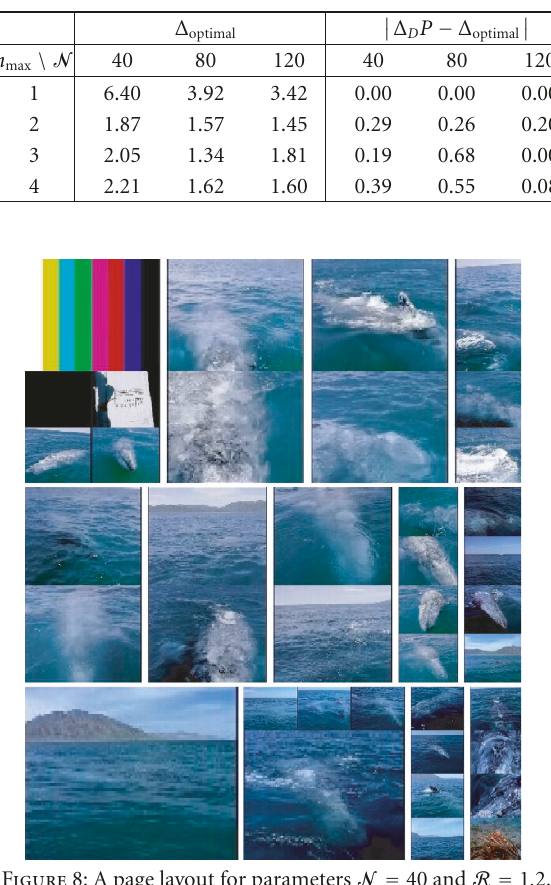
Figure 8: A page layout for parameters N = 40 and R = 1 . 2.